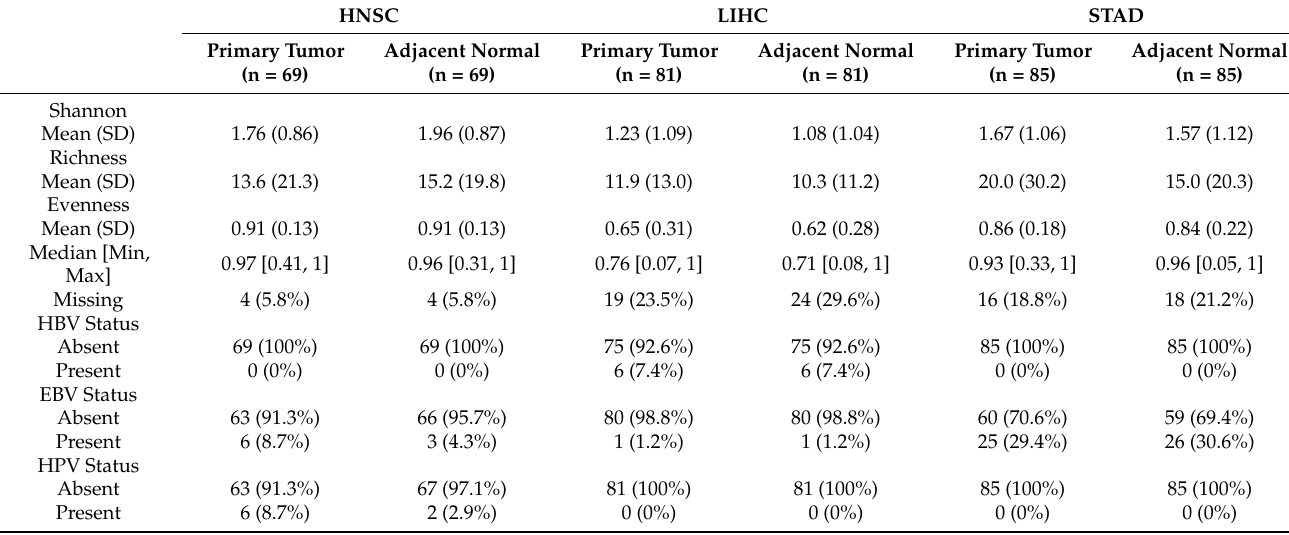
Table 2. Microbial diversity profiles among infection associated cancers cohorts stratified by sample